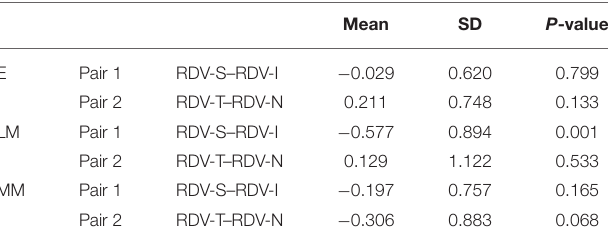
TABLE 3 | Comparative analysis of RDV (RDV-S, RDV-I, RDV-T, and RDV-N) of each group.